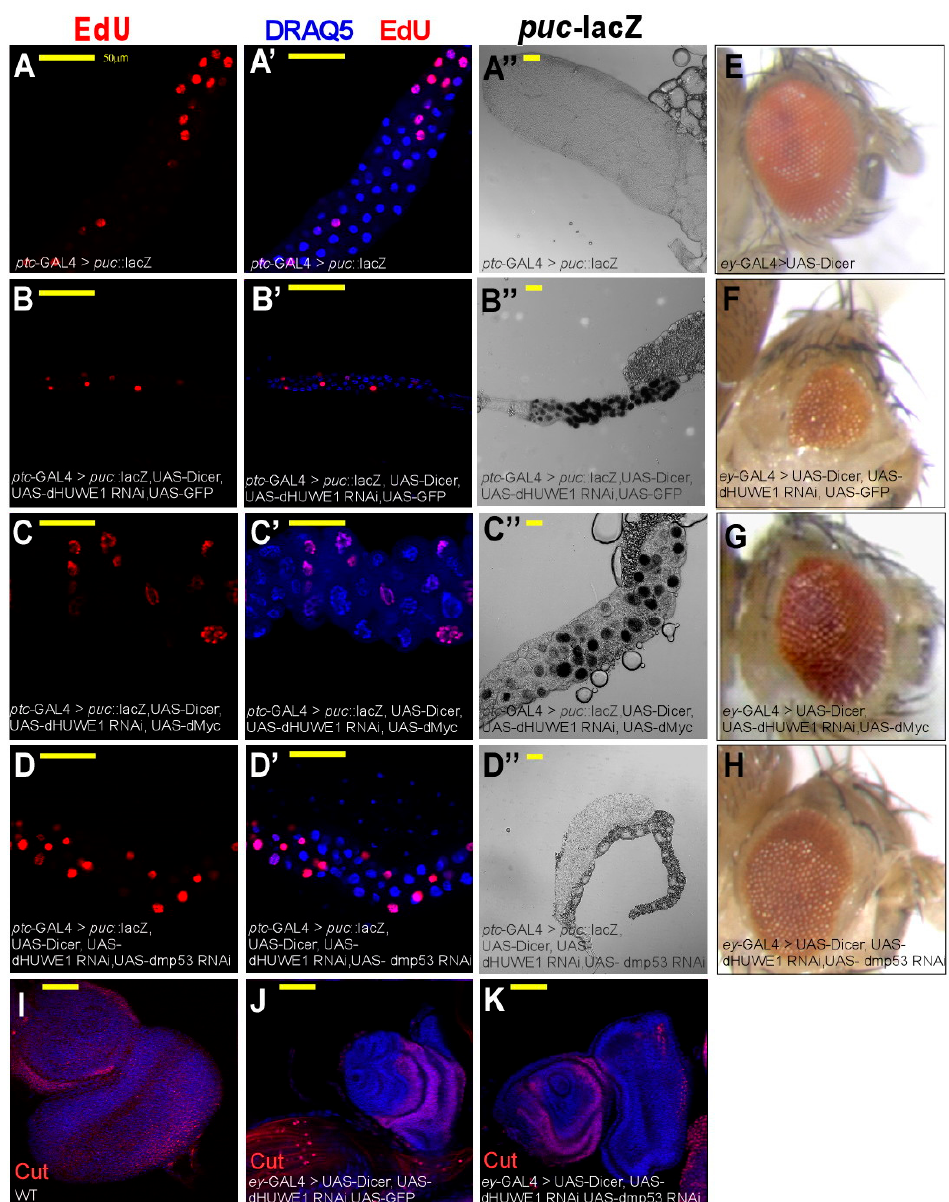
Figure 5. Eliminating dm P53 or expression of dMyc suppresses phenotypes associated with loss of dHUWE1. ( A–D’ ) Indirect immunofluorescence confocal microscopy images of salivary glands derived from wild-type and the indicated transgenic lines under the control of Ptc -Gal4 labeled with EdU to indicate active DNA synthesis. DAPI (blue) marks DNA and the scale bar is 50 µ m. ( A”–D” ) Expression of the JNK pathway reporter puc 69 :: LacZ (black) in salivary glands derived from control and indicated transgenic lines under the control of Ptc -Gal4. ( E–H ) Adult eye morphology in wild-type ( E ), and the indicated UAS-transgenic lines ( E – H ), under the control of the eye-specific Gal4, eyeless -Gal4 ( ey -Gal4). ( I – K ) Confocal images of eye imaginal discs of wildtype ( I ) or the indicated transgenic lines ( J , K ) under the control of ey -Gal4 immuno stained with anti-Cut antibody (red) and DAPI that marks DNA.